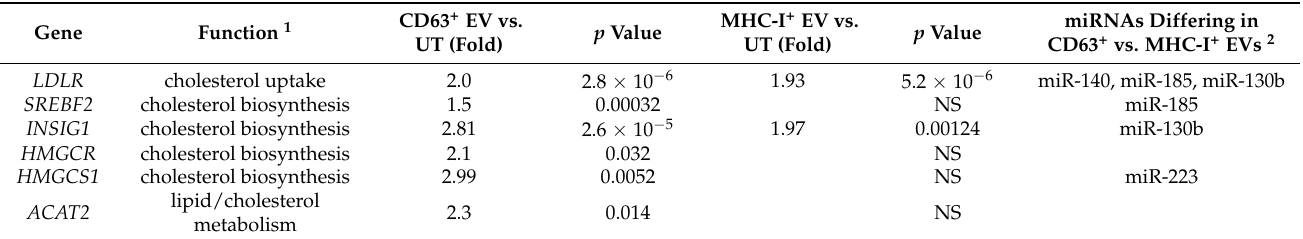
Table 1. Genes involved in cholesterol and lipid metabolism in HUVEC that are differentially regulated by CD63 + vs. MHC-I + EVs and miRNAs known to regulate these genes that differ in CD63 + and MHC-I + EVs released by WT Jurkat T